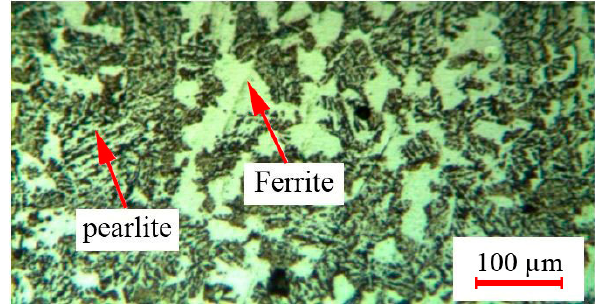
Figure 11. AISI 4130 base metal structure.